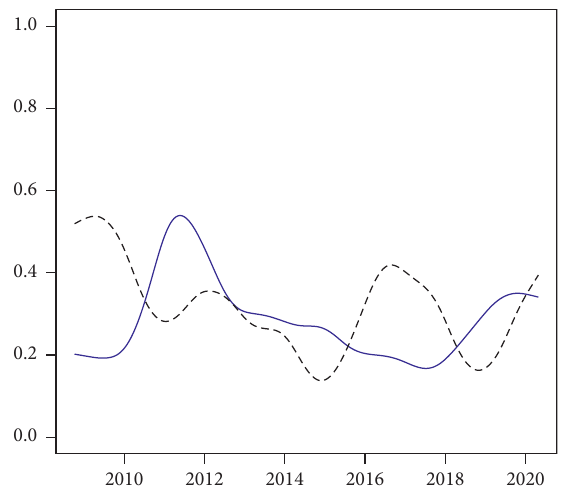
Figure 3: The pattern of total connectedness and average connectedness.